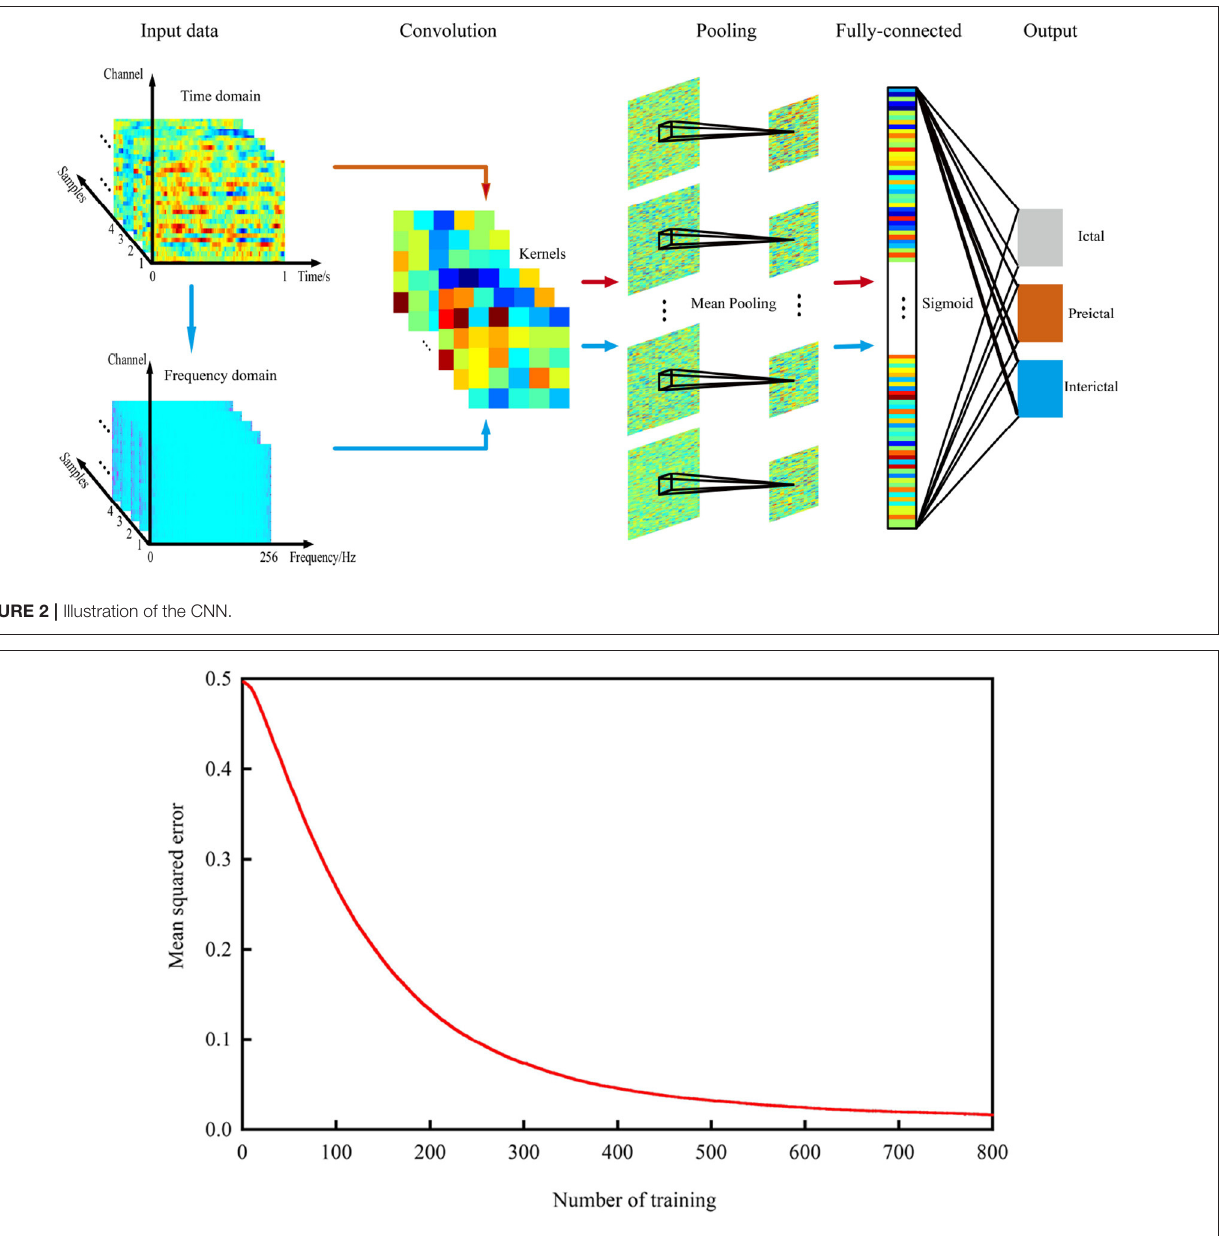
FIGURE 3 | Mean squared